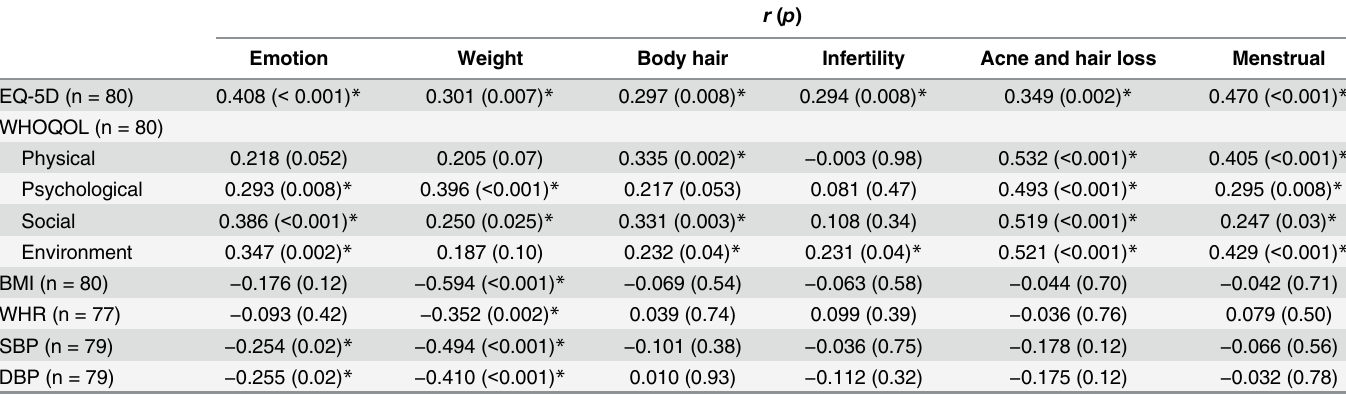
Table 4. Construct validity for Chi-PCOSQ. Note: BMI = body mass index; WHR = waist-hip ratio; SBP = systolic blood pressure; DBP = diastolic blood pressure.